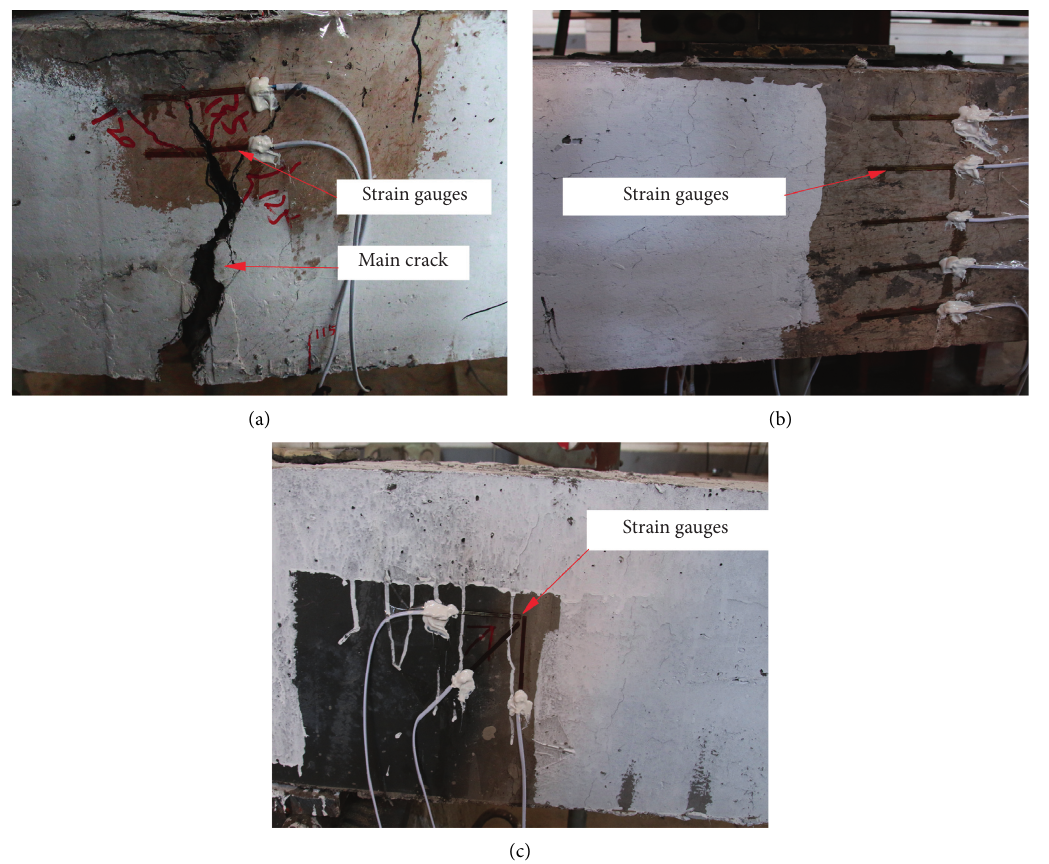
Figure 7: Strain monitoring. (a) Near the crack. (b) Midspan. (c) Near the